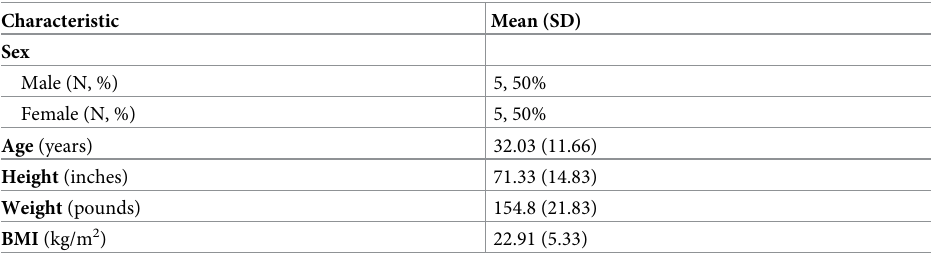
Table 1. Study sample